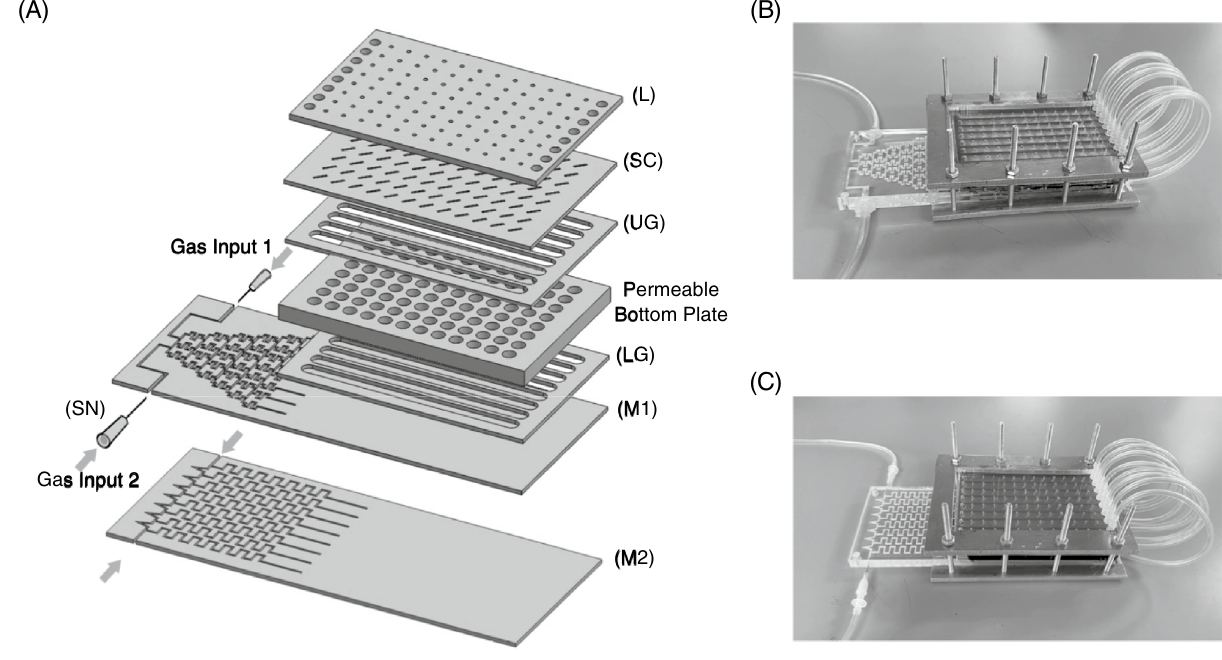
Figure 2. ( A ) A diagram showing the components of the device. The letters correspond to the structures shown in Fig. 1 with the addition of two syringe needles (SN) to connect the gas feeds. Two different manifolds are used. The mixing tree manifold (M1) is used to screen response to eight different oxygen environments. The gas partitioning manifold (M2) supplies one oxygen environment to Rows A-D and a second oxygen environment to Rows E–H. ( B ) Shows the assembled device with manifold M1 and ( C ) the assembled device with manifold M2. The tubing loops recirculates the gas flow from below the permeable bottom wells in each row to over the top of the